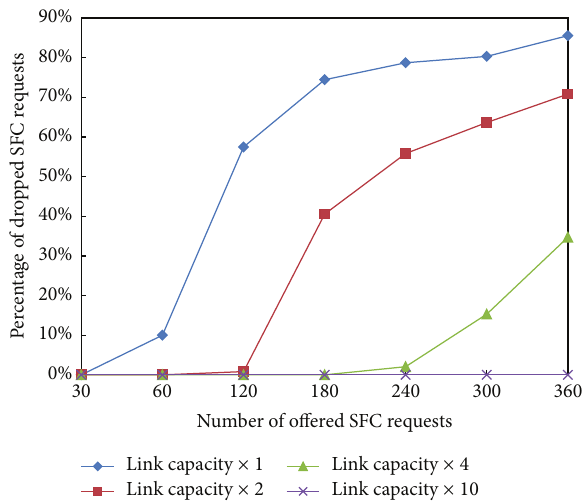
Figure 7: Dropped SFC percentage as a function of the number of SFCs offered. Thefour curves arereported forthe basicscenario case and the ones in which the link capacities are doubled, quadrupled, and increased by 10